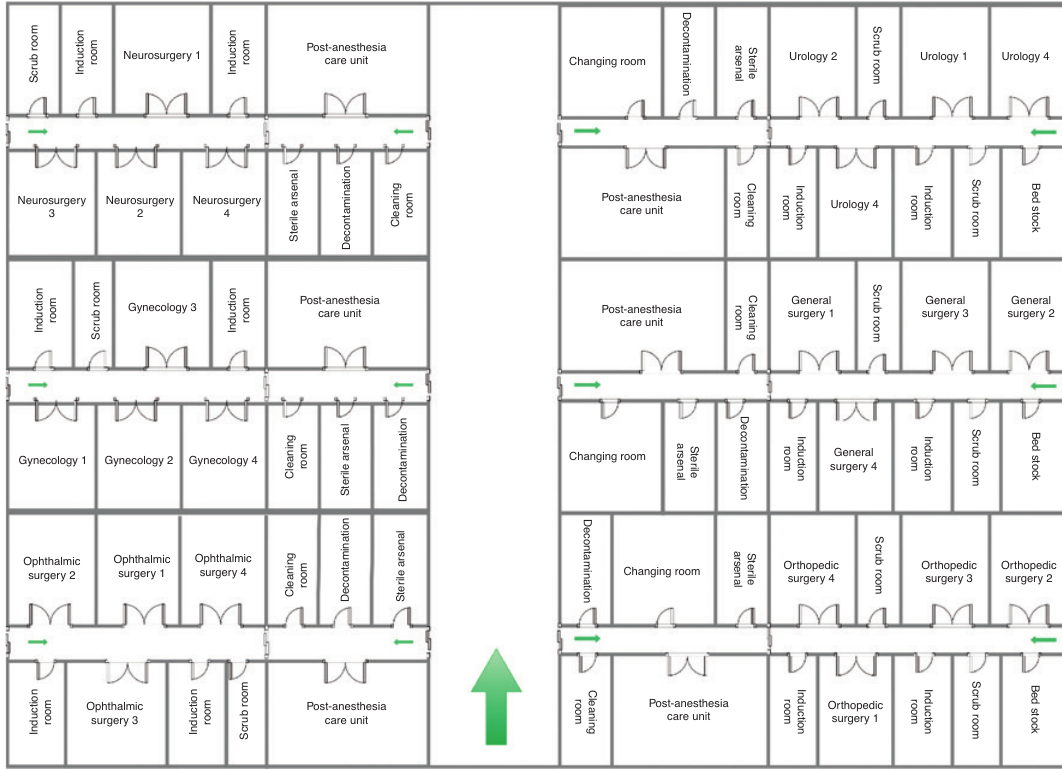
Figure 7: SOTLP: Final OT